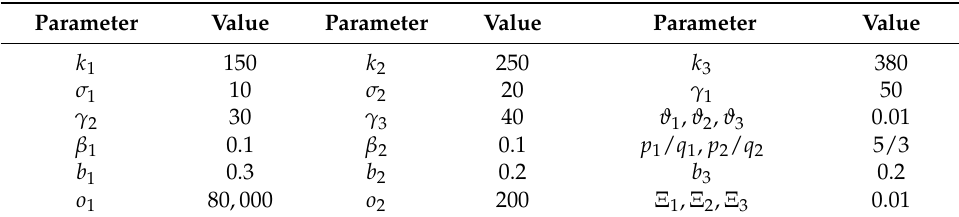
Table 2. Parameters of DFA-SMB controller.